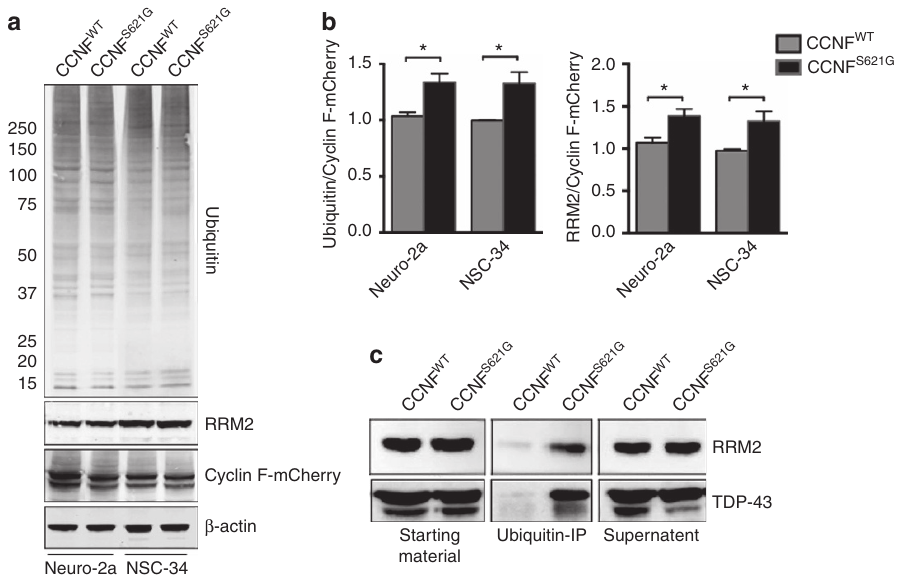
Figure 3 | Increased ubiquitinated proteins in neuronal cell lines expressing mutant cyclin F. NSC-34 and Neuro-2a cells were transfected with wild-type or mutant cyclin F (p.S621G) expression constructs, and cells were collected after 24h. ( a , b ) Cells transfected with mutant cyclin F (p.S621G) show increased levels (normalized to transfected cyclin F-mCherry) of ubiquitinated proteins and a known cyclin F–SCF complex target, RRM2 (Neuro-2a: Ubiq/cyclin F, P ¼ 0.025; RRM2/cyclin F, P ¼ 0.020. NSC-34: Ubiq/cyclin F, P ¼ 0.032; RRM2/cyclin F, P ¼ 0.023; two-tailed unpaired Student’s t -test). ( c ) Immunoprecipitation (IP) of ubiquitinated proteins from transfected Neuro-2a cells (wild-type and mutant cyclin F (p.S621G)) show elevated levels of ubiquitinated RRM2 and TDP-43 in neuronal cells expressing mutant cyclin F. Full-length blots are presented in Supplementary Fig. 4. Data are represented as mean ± s.e.m. n ¼ 3; * P o